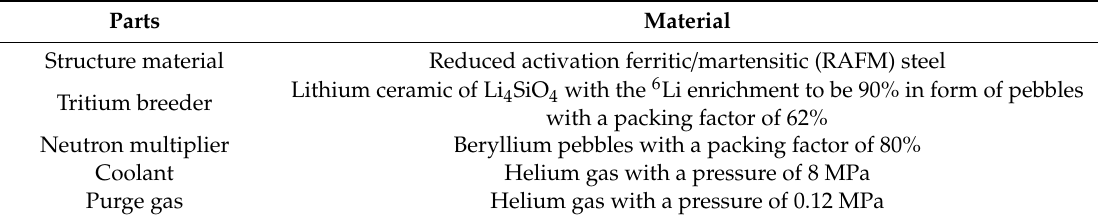
Table 2. Material selections of the HCSB blanket.